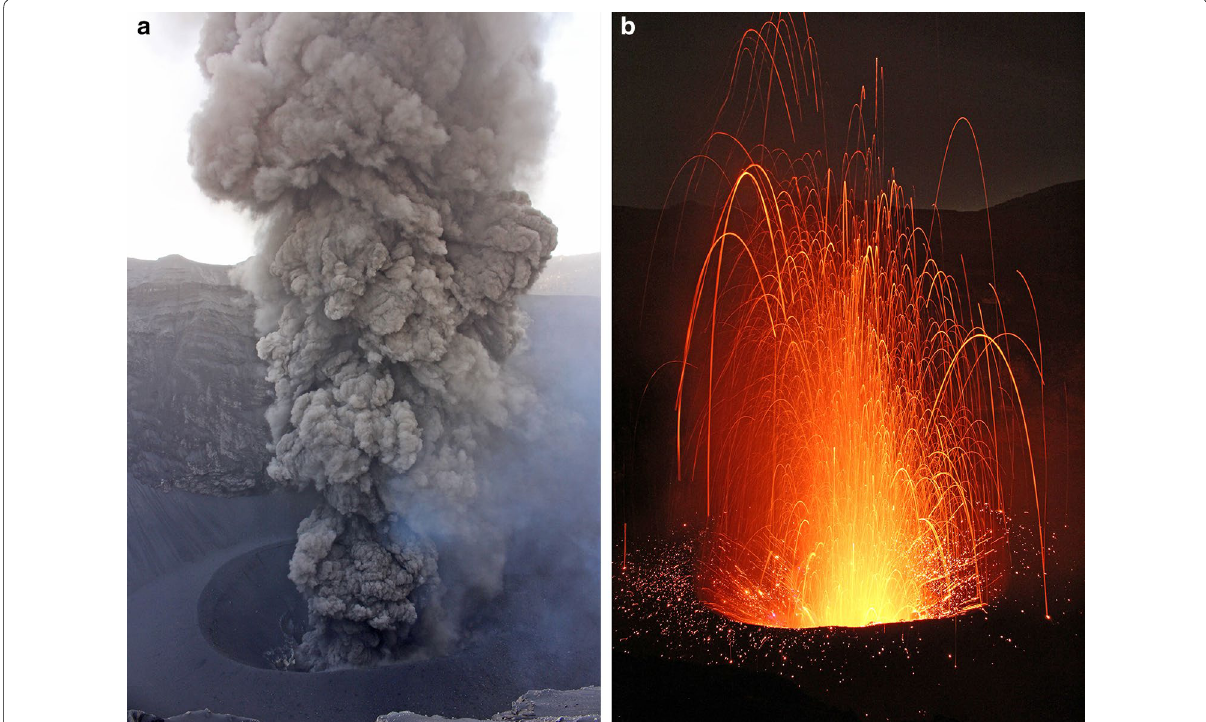
Fig. 1 Photographs of typical eruption styles during the 2014–2015 magmatic activity of Nakadake first crater. a Ash-emitting activity from vent 141 in the daytime of January 13, 2015. b Strombolian eruption during the night of January 13,